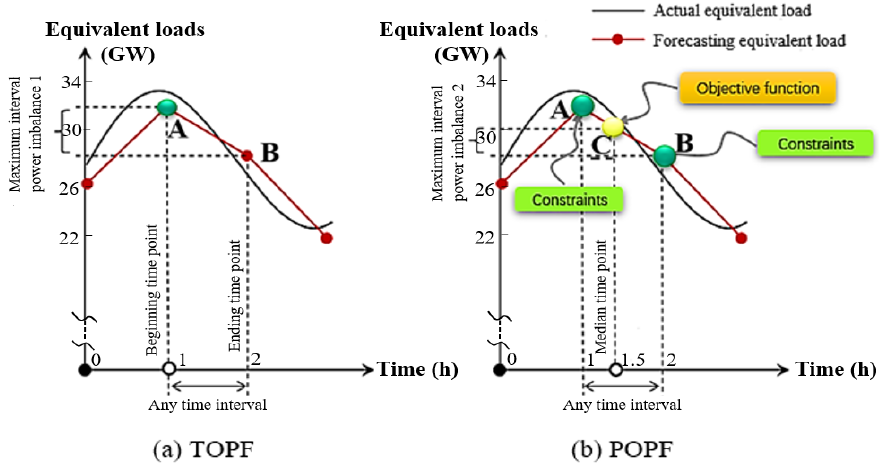
Figure 2. Applications of a discrete time optimal power flow for continuous